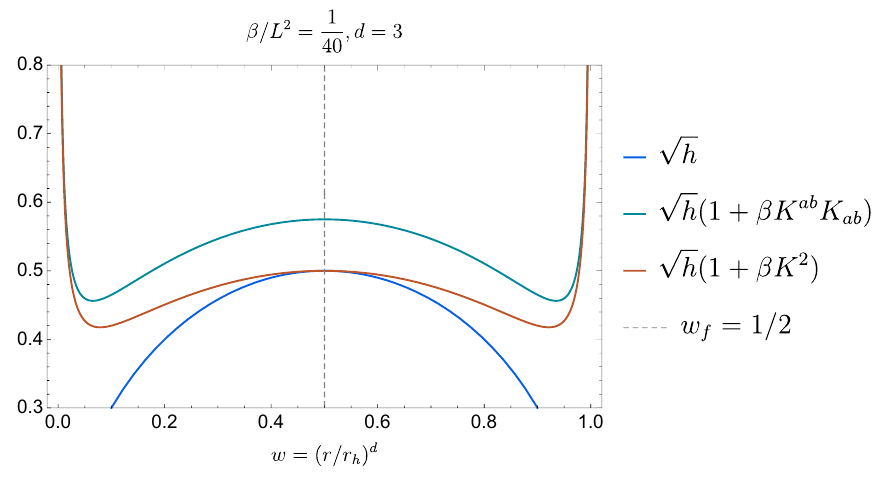
Figure 10 . The volume measures on the constant − r slices (rescaled by L d /r d with distinct extrinsic curvature terms. We have fixed β